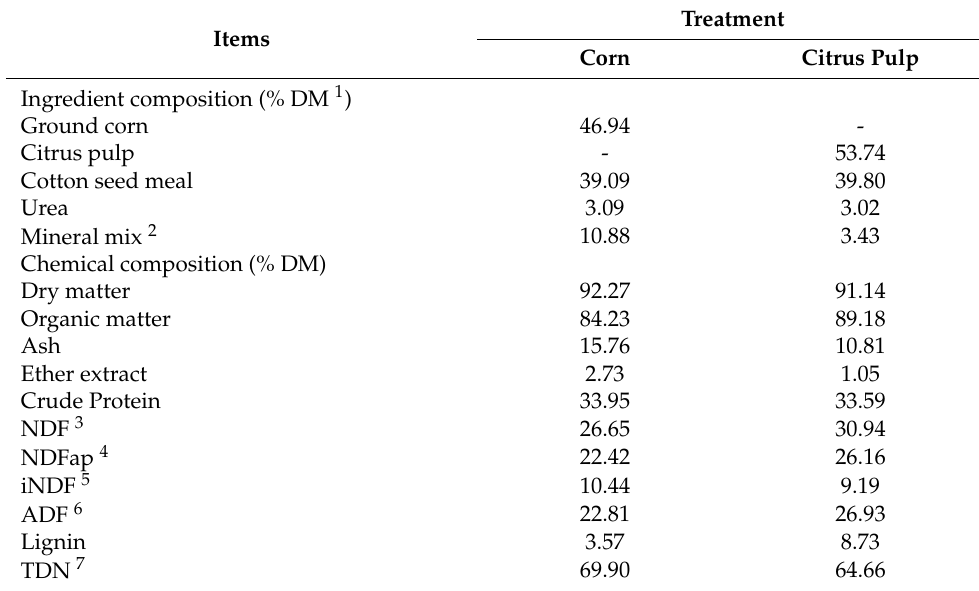
Table 1. Ingredient and chemical composition of supplements in experiments 1 and